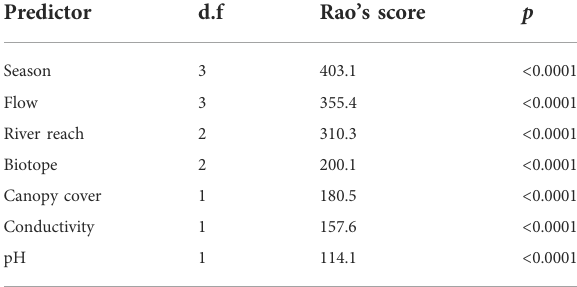
TABLE 2 General results from a multivariate abundance generalised linear model with the combination of predictor variables that best explain variation in macroinvertebrate species composition. Results are expressed as a marginal analysis of variance, with model degrees of freedom (d.f.), Rao ’ s score test statistic, and p -value for each predictor. Residual d.f. =